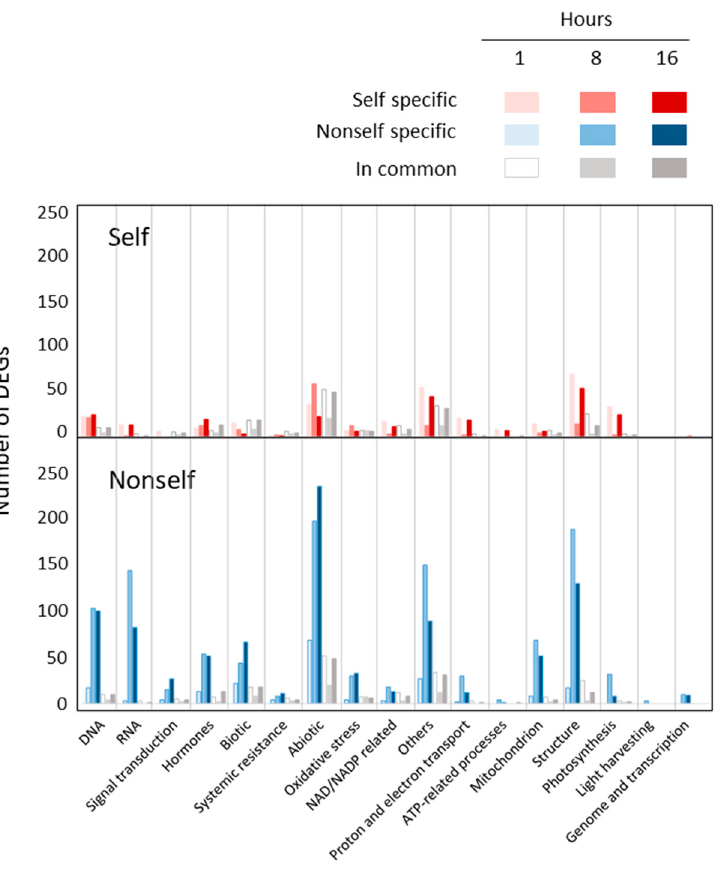
Figure 4. Number of either specific or common filtered DEGs in the main GO groups according to different self- and nonself-DNA treatments (at 1, 8 and 16 hpt). Specific DEGs after exposure to self-DNA are mostly shown at 1 and 16 hpt, whereas the nonself-DNA treatment is associated with an increased number of DEGs at 8 and 16